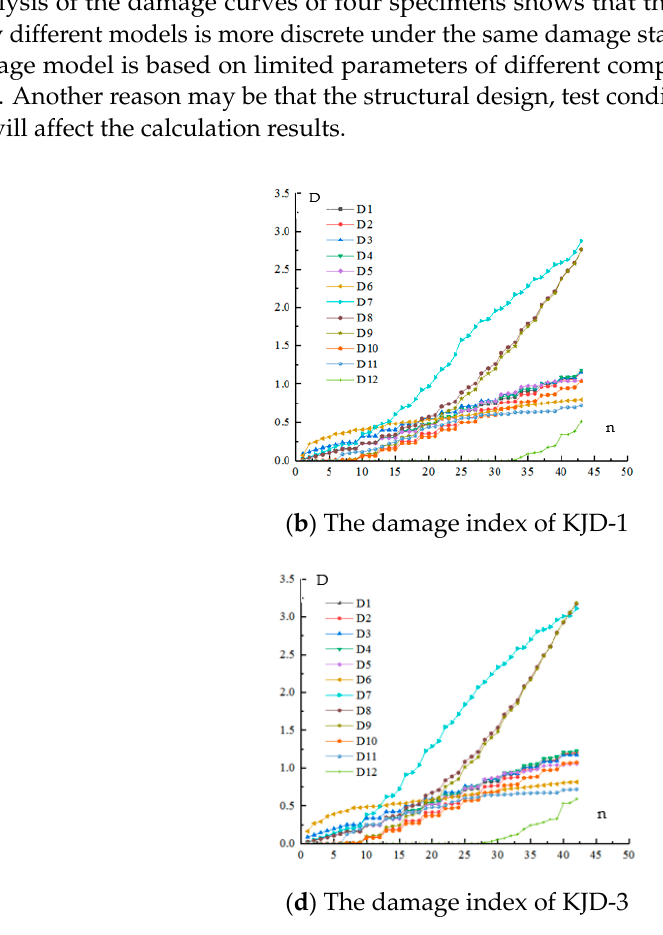
Figure 18. The damage index of KJD-0~KJD-3.